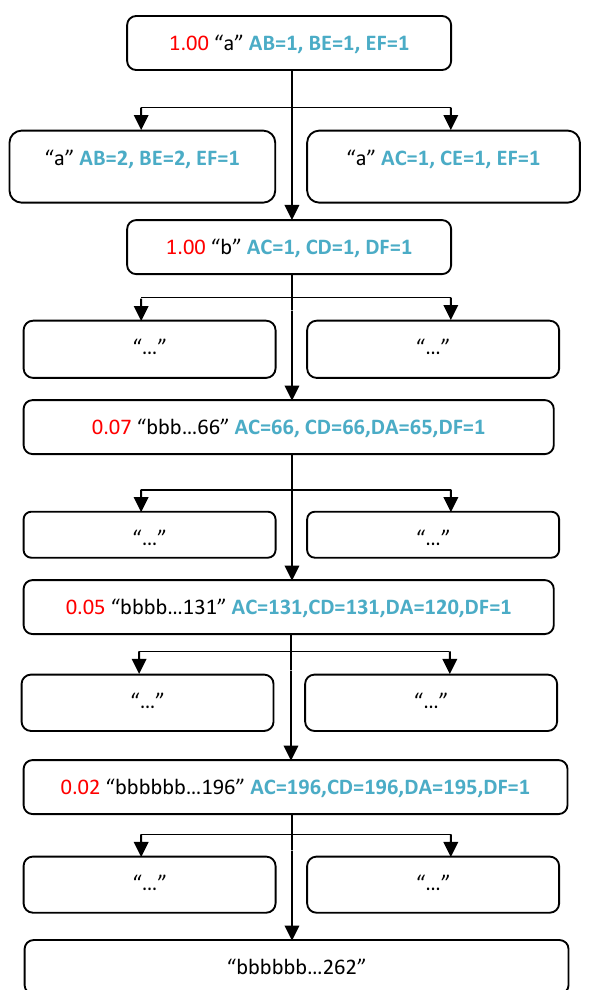
Fig. 2 : Production of test input for